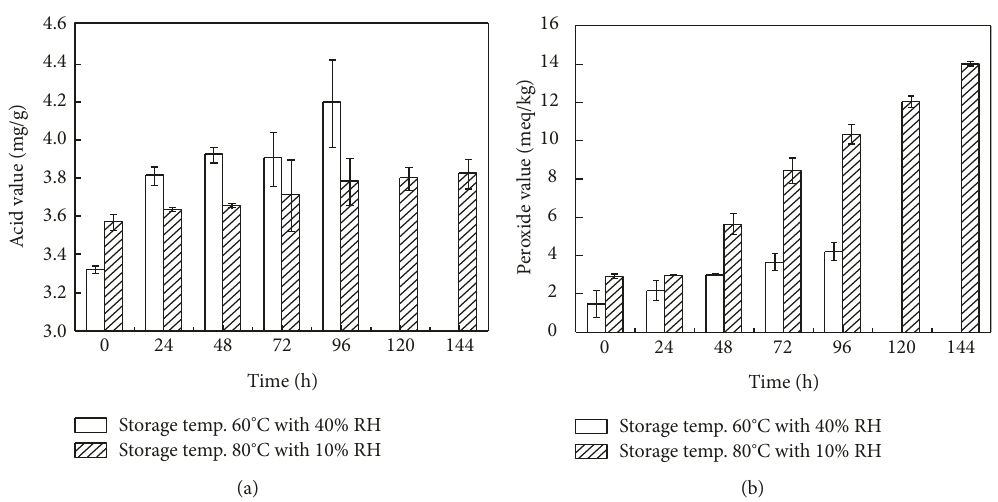
Figure 3: Acid values and peroxide values of perilla seed oil for various storage temperatures, relative humidity, and time periods. (a) Acid value. (b) Peroxide value. Table 1: Statistics of acid values and peroxide values of perilla seed oil according to storage time.